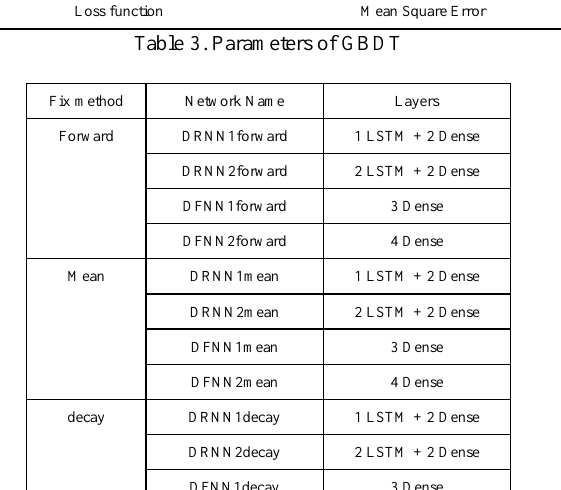
Table 2. Features of input data